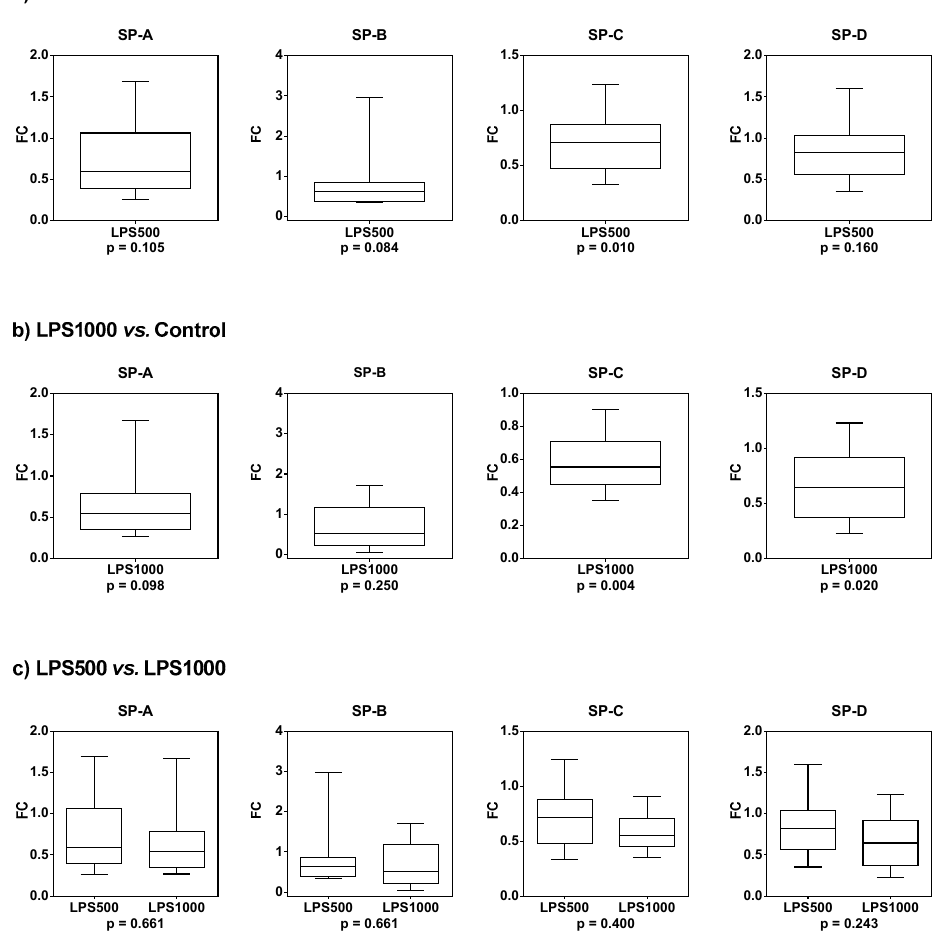
Figure 5. The gene expression of SPs after treatment with lipopolysaccharide (LPS) at a concentration of ( a ) 500 μ g/kg or ( b ) 1000 μ g/kg compared to the control group. ( c ) Comparison of SP gene expression after treatment with 1000 and 500 μ g/kg LPS.